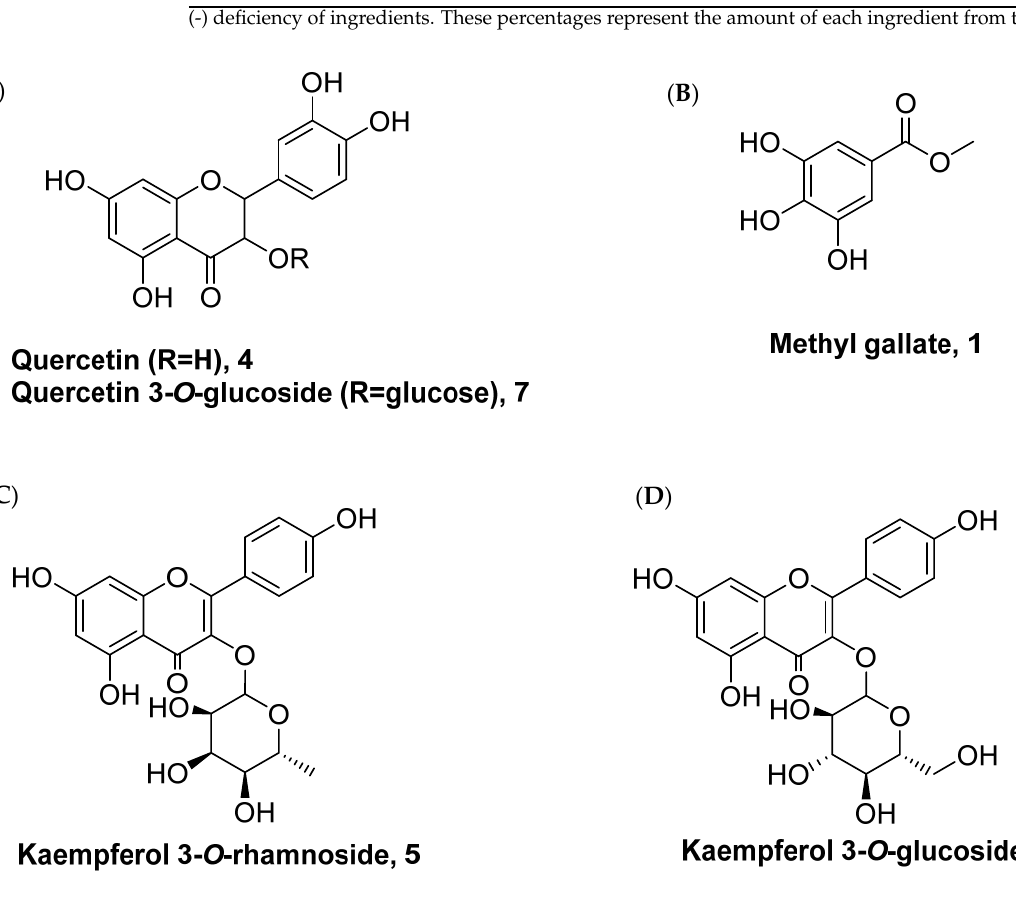
Figure 1. Chemical structure of the compounds isolated from P. lentiscus bark.